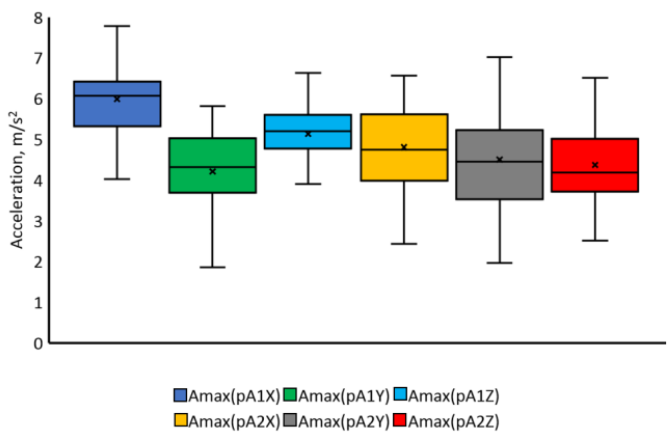
Figure 13. Summary of the maximal acceleration values obtained in the study of reaching movements in the acceleration phase.